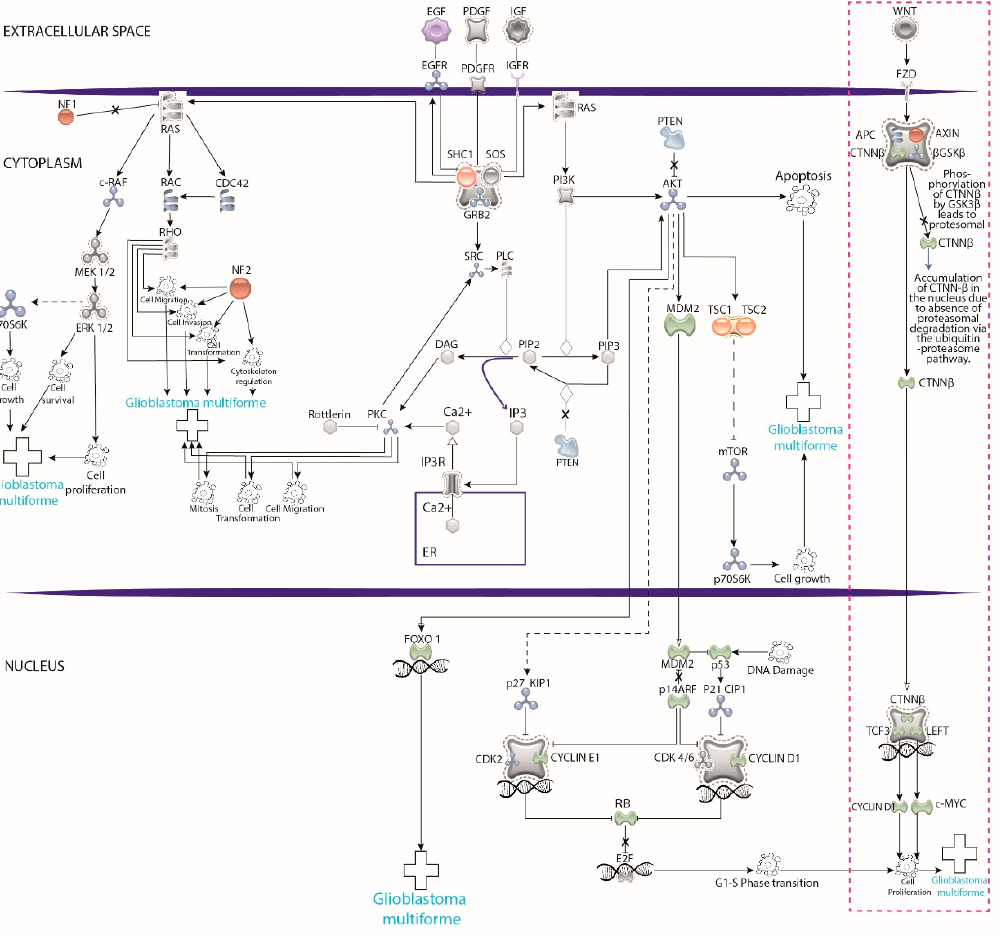
Figure 3. Pathways involved in the development and establishment glioblastoma (GB) at the mo- lecular level. The pink dotted rectangle highlights that research using xenotransplants into zebrafish has focused only on the Wnt pathway, leaving a significant opportunity window to explore the remaining pathways. Graphics created in illustrator program based on the model of https://geneglobe.qiagen.com (accessed on 10 July 2021).